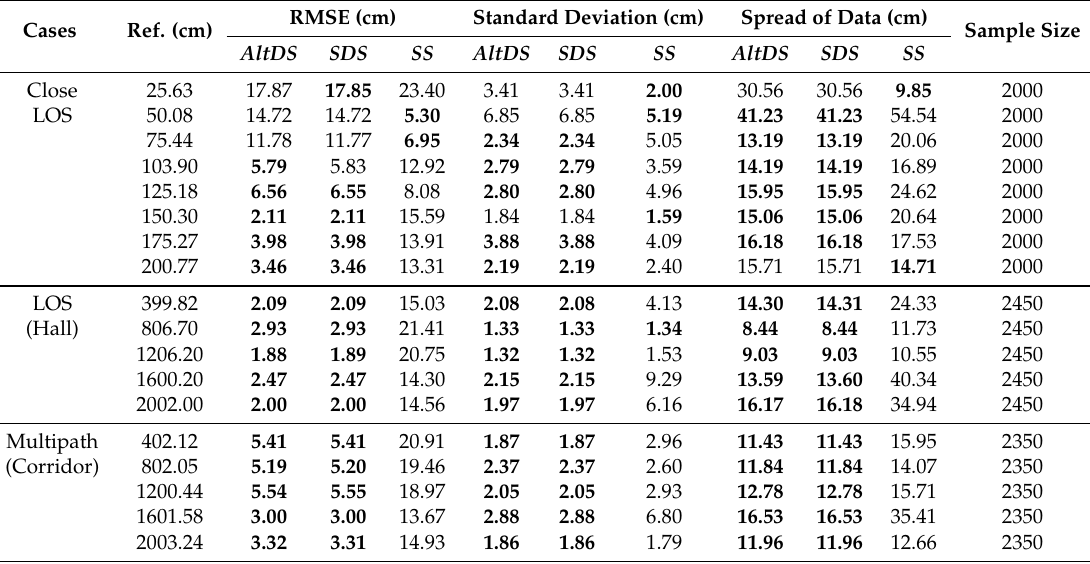
Table 5. Experiment evaluation results for the special case (Type II) at different